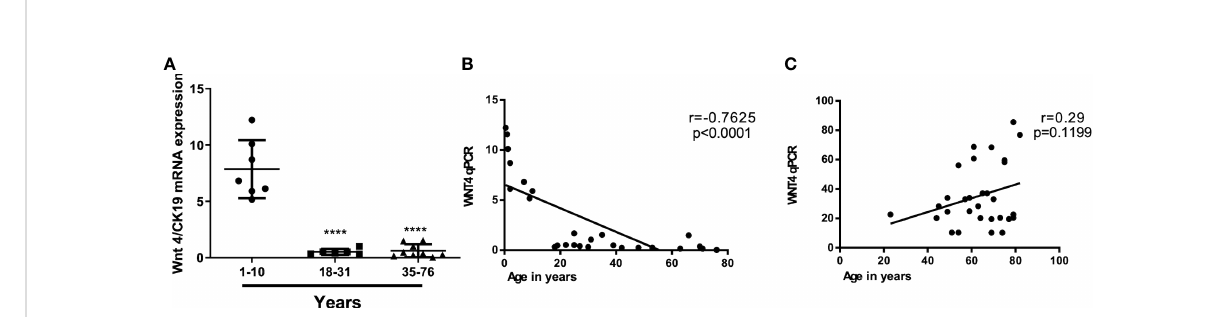
FIGURE 2 Age-independent WNT4 mRNA levels in thymic epithelial tumors (TETs) as compared to declining levels with age in non-neoplastic thymuses. (A) : WNT4 mRNA expression by Q-PCR in 21 normal thymuses in different decades from childhood thymuses (n = 6) to adult normal thymuses (n = 15); (B) : Correlation between WNT4 expression levels and age in non-neoplastic thymuses (NT) and (C) : Correlation between WNT4 expression levels and age in B3 thymomas and thymic carcinomas (1). Pearson ’ s correlation (r) values are indicated within each